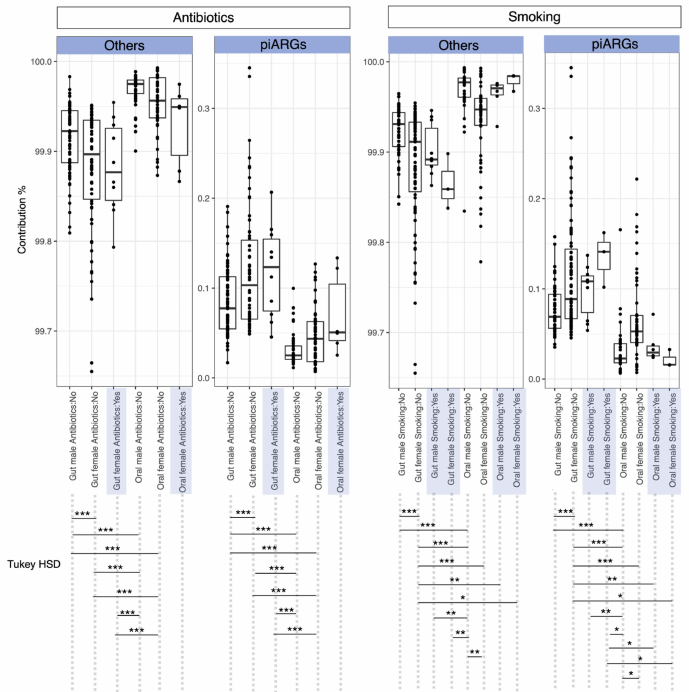
Figure 2. Bray-Curtis contribution of predictive antimicrobial resistance genes (piARGs) to the overall beta diversity within the categories. The plot shows N ( N − 1 ) / 2 pair-wise